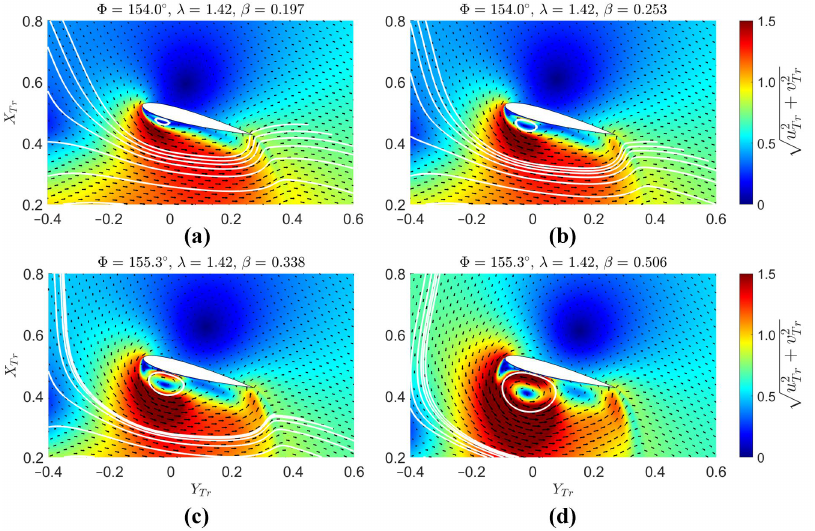
Figure 14. The velocity fields in the blade reference frame after it reached the maximum torque of 4 blockage ratios: 19.7% ( a ), 25.3% ( b ), 33.8% ( c ), and 50.6% ( d ). On each figure, the lower surface is the turbine inner side and the upper surface is the turbine outer side.